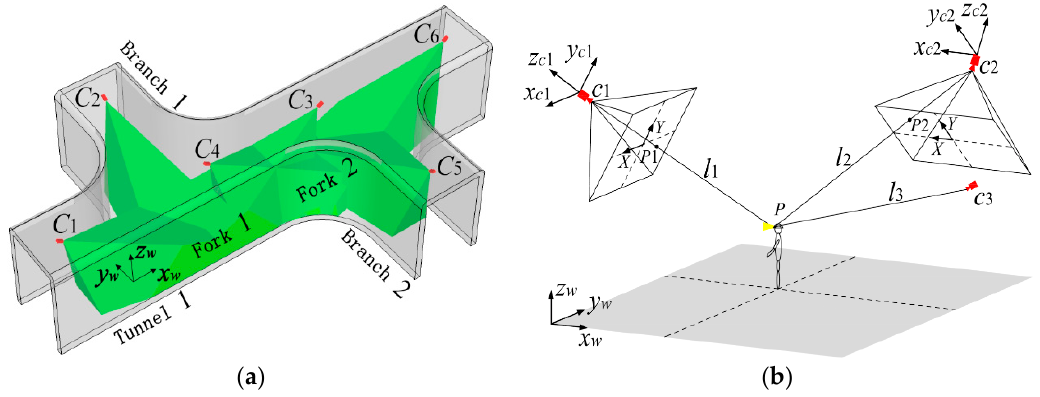
Figure 6. Video collaborative localization of miner’s lamp based on WMSNs: ( a ) localization scene; and ( b ) camera vision imaging model.